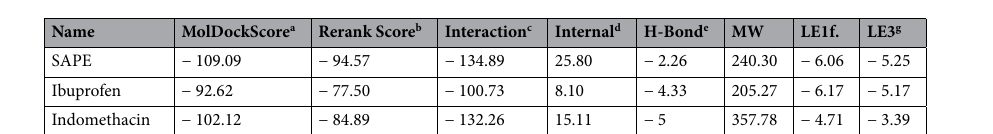
Figure 1. [i] ( A ) Protein–ligand interactions between SAPE and active site residues of COX-2 enzyme ( B ) Binding mode of SAPE at the active site residues of COX-2 enzyme ( C ) Protein–ligand interactions between ibuprofen and active site residues of COX-2 enzyme ( D ) Binding mode of ibuprofen at the active site residues of COX-2 enzyme ( E ) Protein–ligand interactions between indomethacin and active site residues of COX-2 enzyme ( F ) Binding mode of indomethacin at the active site residues of COX-2 enzyme. [ii] MD simulation showing the RMSD plot of the docked protein ligand complex showing that SAPE-COX-2 is more stable than the ibuprofen and indomethacin complex. [iii] ( a ) Molecular orbital depicting the HOMO (E = -6.29 eV) of SAPE calculated at DFT/B3LYP/6-31G level of theory. ( b ) Molecular orbital depicting the LUMO (E = -1.09 eV) of SAPE calculated at DFT/B3LYP/6-31G level of theory.